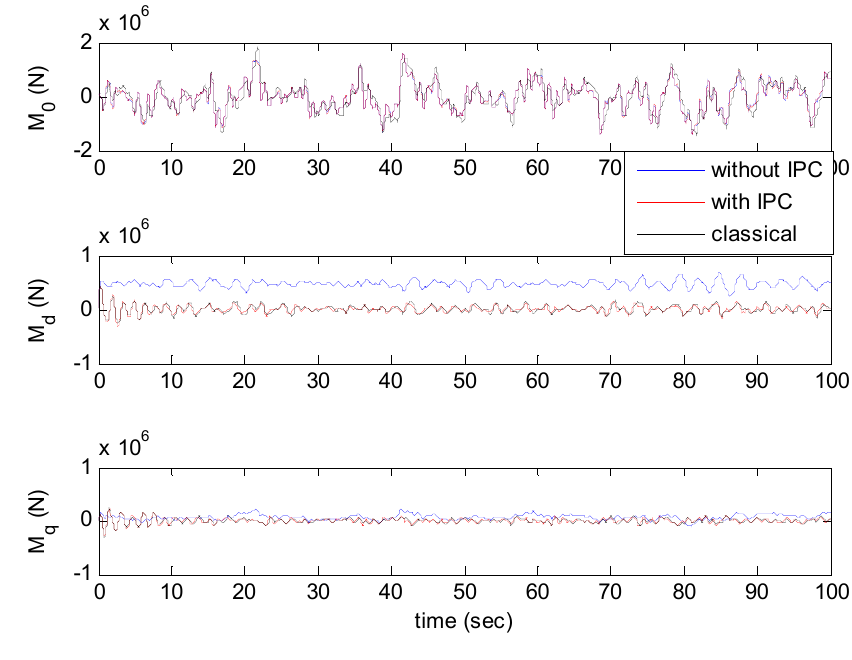
Figure 14. Responses of collective moment (top), tilt moment (middle) and yaw moment